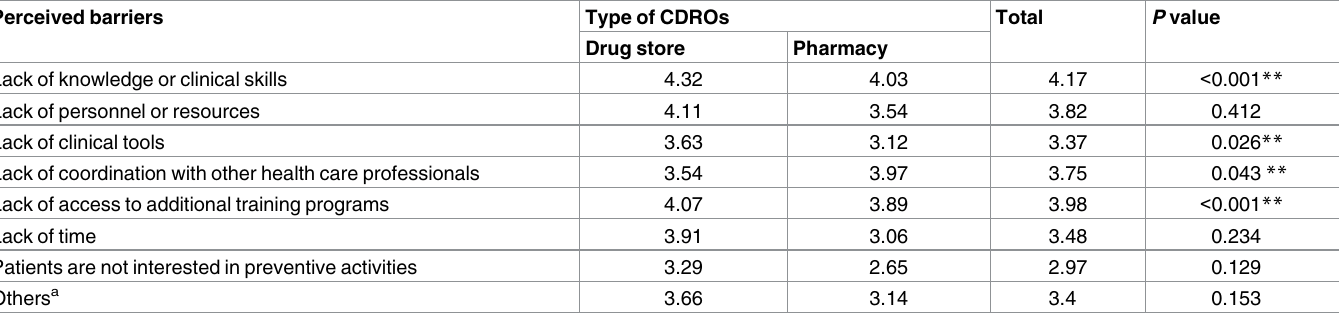
Table 5. Perceived barriersto the provision of public health servicesin CDROs (Mean) (Likert scale: 0 = not at all problematic to 5 = extremely problematic), Amhara, Ethiopia, N = 412. Perceived